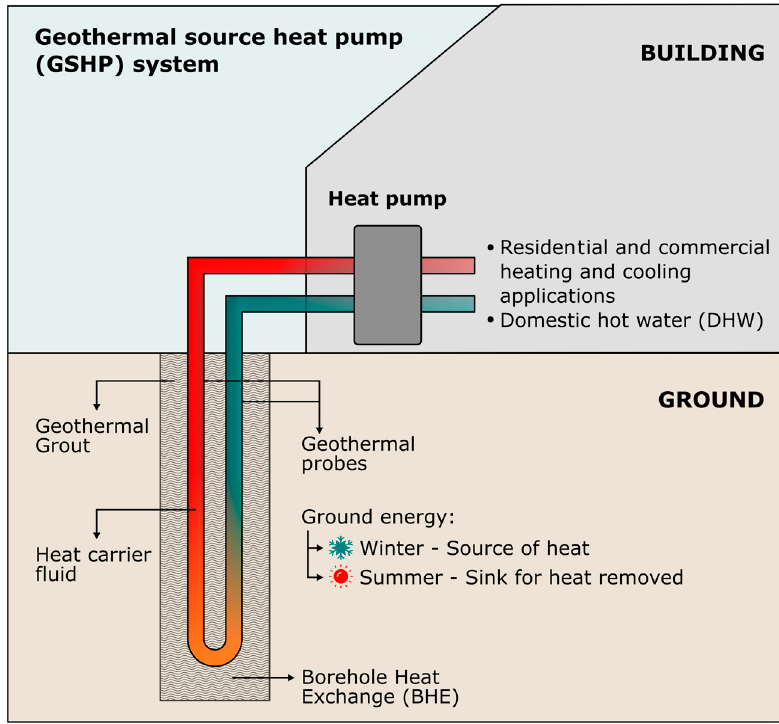
Figure 1. Geothermal source heat pump.